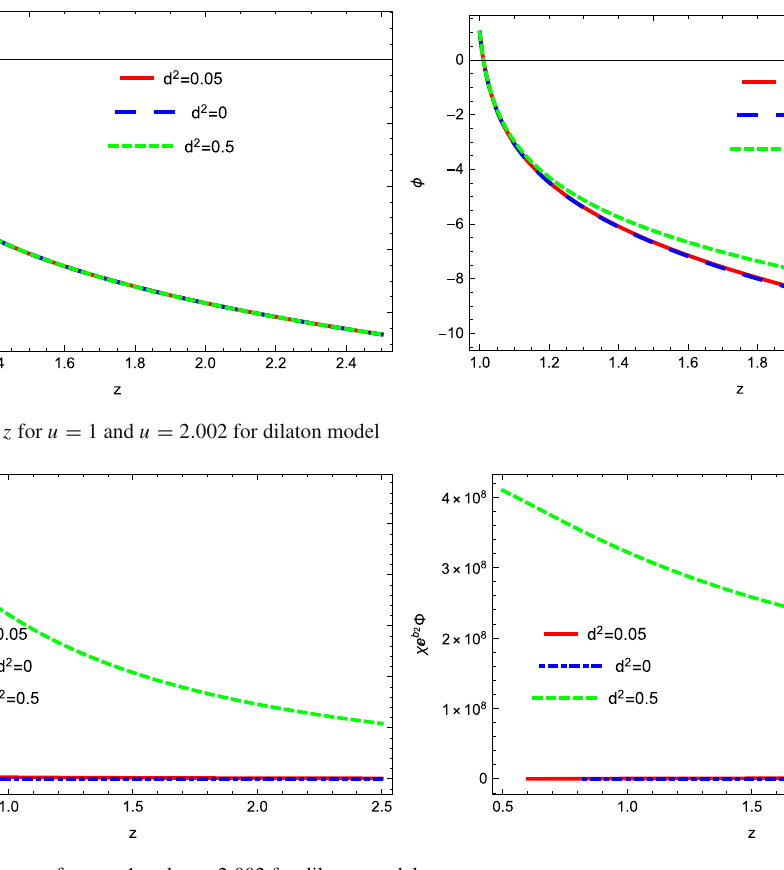
Fig. 29 Plot of χ e b 2 φ verses z for u = 1 and u = 2 . 002 for dilaton model